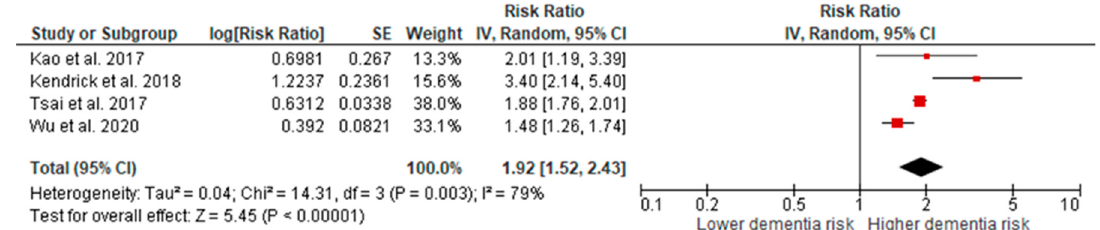
Figure 2. Meta-analysis showing the pooled risk of dementia in AKI patients compared to patients without AKI.